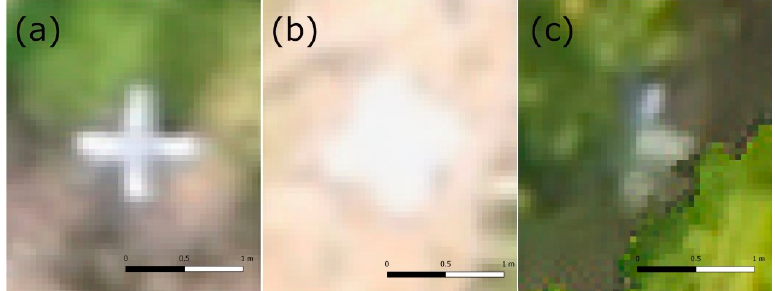
Figure 10. Conditions influencing the identification of check points’ centres. ( a ) ideal conditions, ( b ) too sharp light and bright background, ( c ) point partially blended with surrounding vegetation. Width of the crosses’ arms is 15 cm, i.e., 3 pixels under ideal conditions.